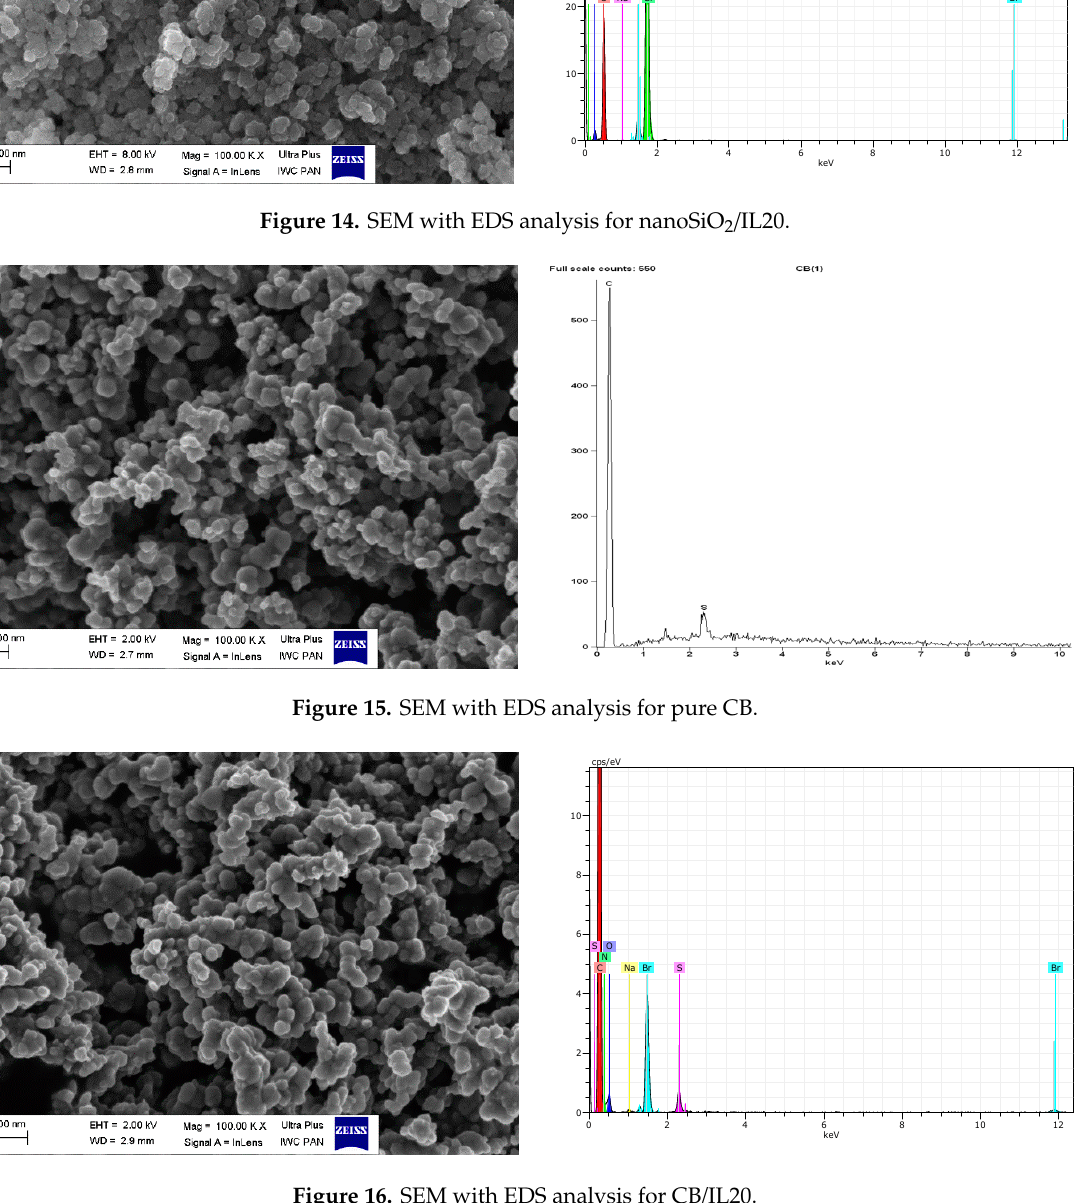
Figure 16. SEM with EDS analysis for CB/IL20.